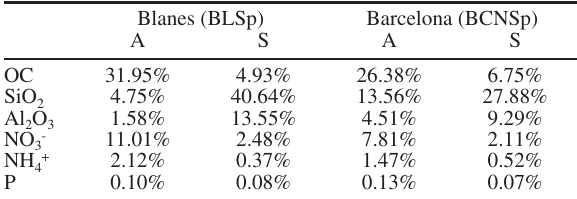
, carbon trioxide; SiO , 3 2